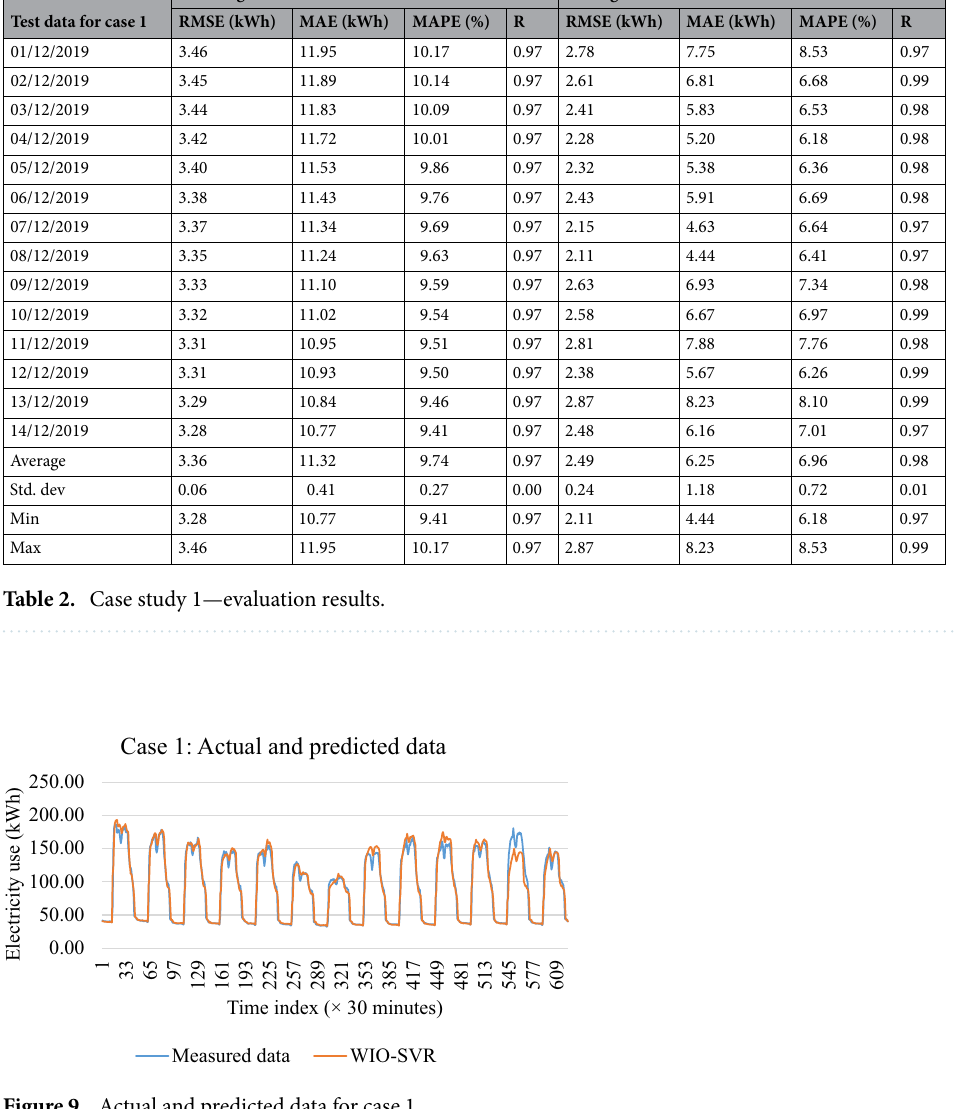
Figure 9. Actual and predicted data for case 1.